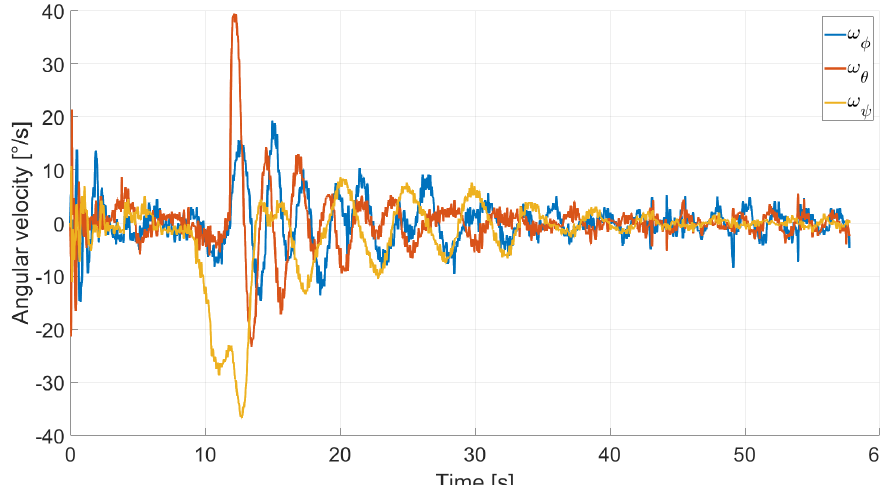
Figure 14. Case 1: angular velocity.